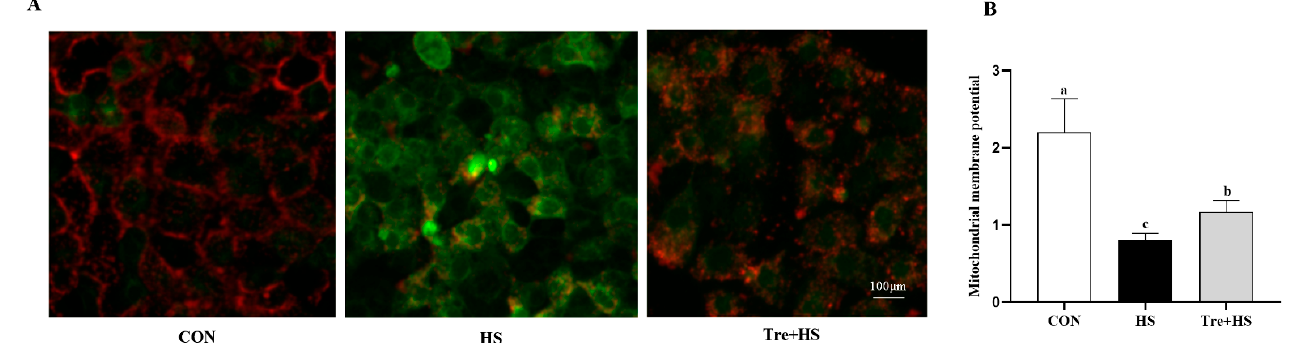
Figure 4. Effects of trehalose on mitochondrial membrane potential in heat ‐ stressed IPEC ‐ J2 cells. IPEC ‐ J2 cells were cultured at 37 °C until the end of the experiment (control, CON); exposed to heat stress for 2 h (43 °C, HS); or pretreated with 10 mM trehalose at 37 °C for 4 h prior to heat stress exposure for 2 h (Tre + HS). Mitochondrial membrane potential was analyzed using JC ‐ 1 assay ( A , B ). Scale bar = 100 μ m. Magnification 200×. Data are shown as mean ± SD (n = 3). Means for variables that do not share a common letter differ significantly ( p < 0.05).